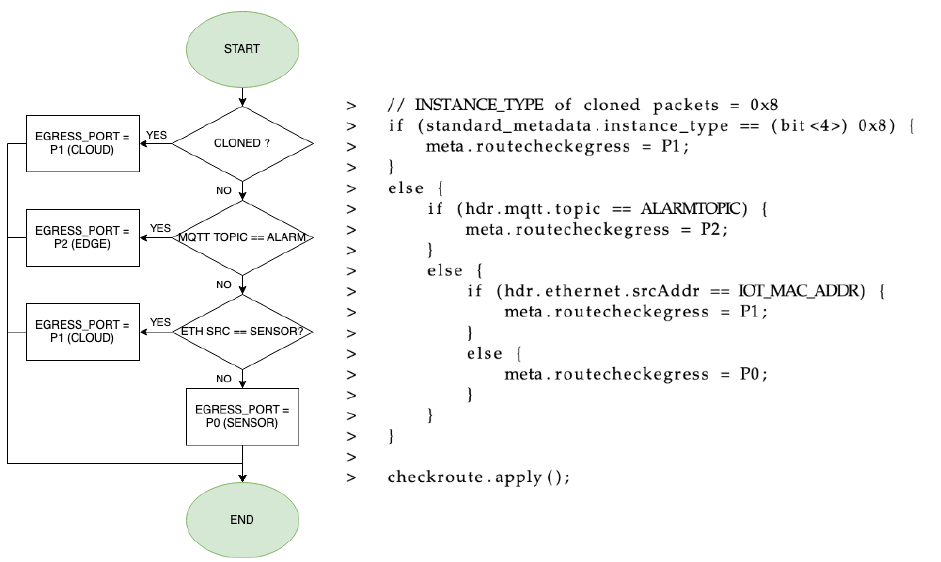
Figure 7. Flux diagram and code for the egress